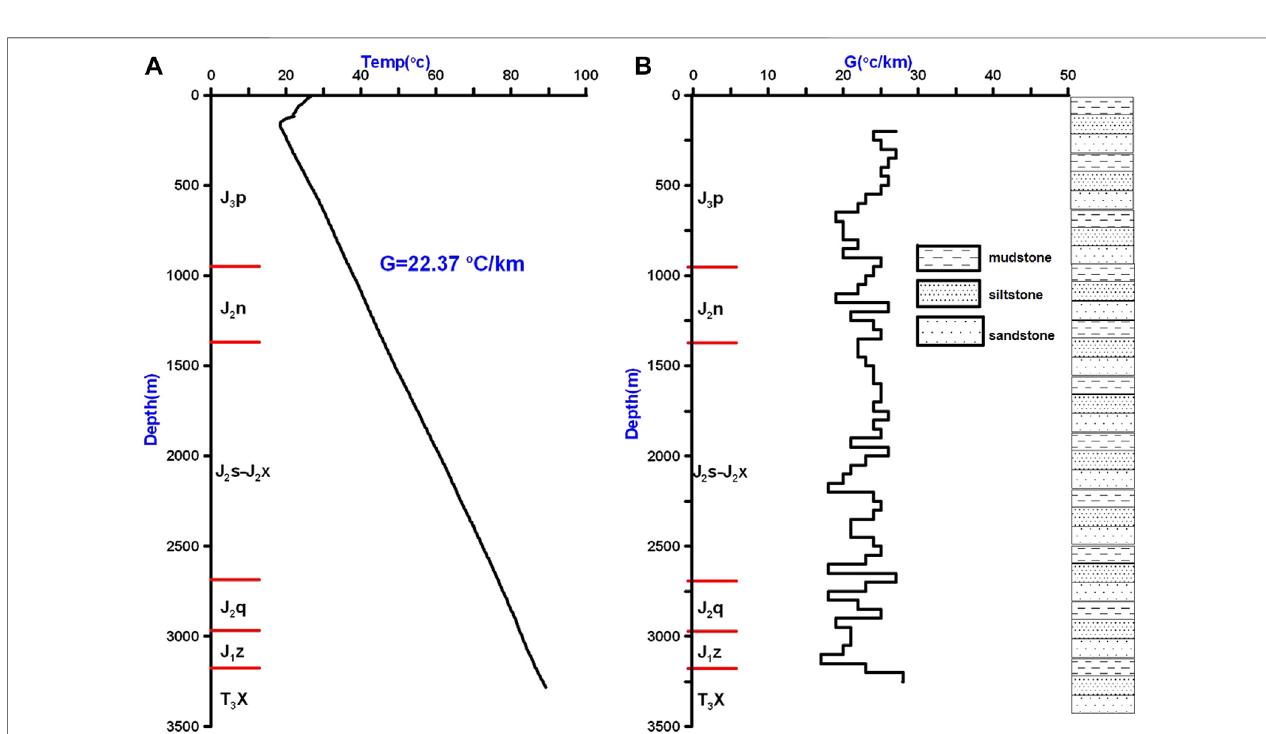
FIGURE 7 | Temperature logging curve (A) and the temperature gradient (B) of borehole Cq128.